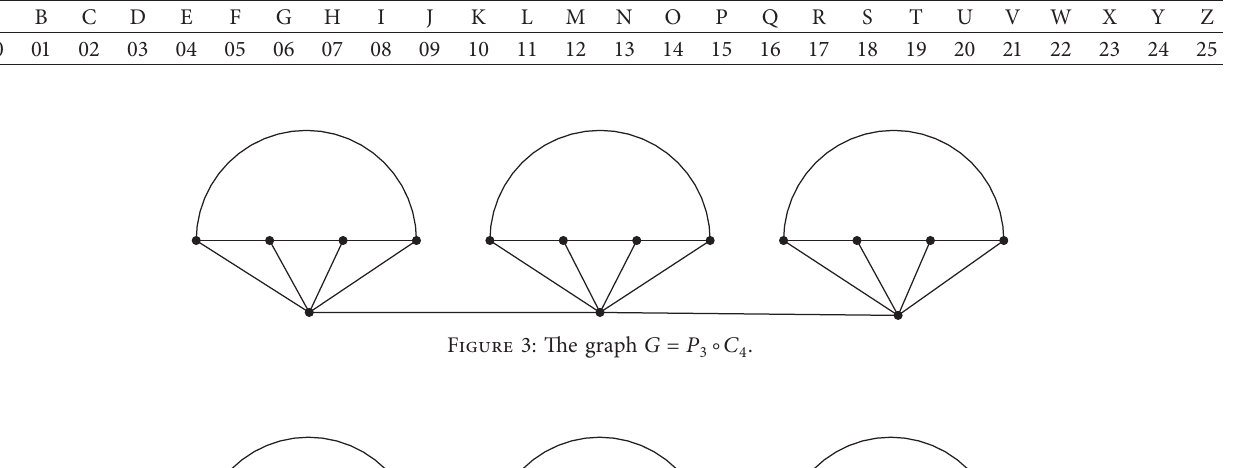
Table 5: Encoded table based on the letters of the